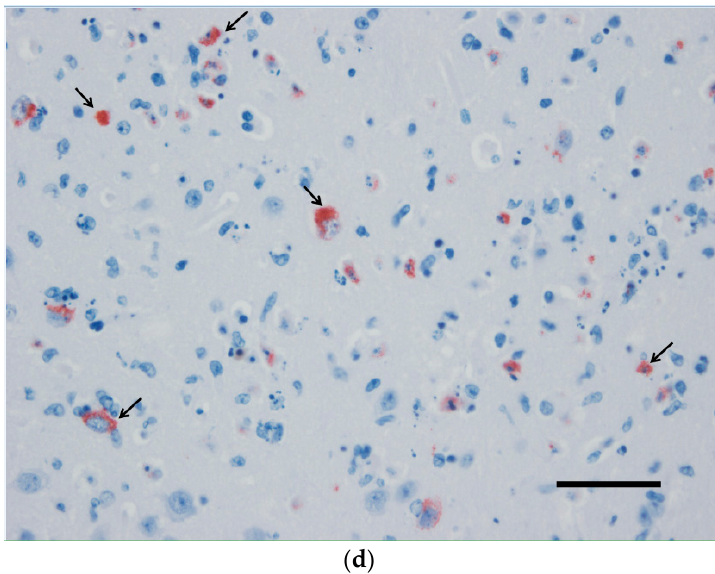
Figure 1. The brain of a wild-type 129/Sv mouse injected with the Usutu virus via the intradermal route. Massive neuronal death demonstrated by karyorrhexis and karyolysis ( a , b ) in correlation with intense immunohistochemical labeling of USUV antigens ( c , d ). ( a , b ) Hematoxylin and eosin staining, ( b , c ) hematoxylin counterstain. Scale bars a and c = 200 µm, magnification 100×; Scale bars b and d = 50 µm; magnification 200×.